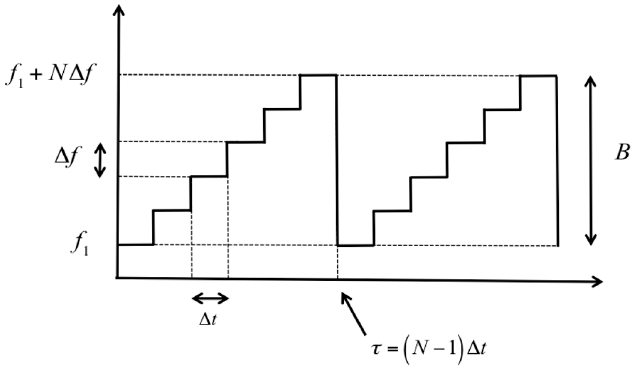
Figure 2. Sweeping of a step frequency continuous wave (SFCW) radar: f 1 is the initial frequency, Δ f is the step frequency, B is the bandwidth, Δ t is the tone duration, N is the number of frequencies, and τ is the sweep time.